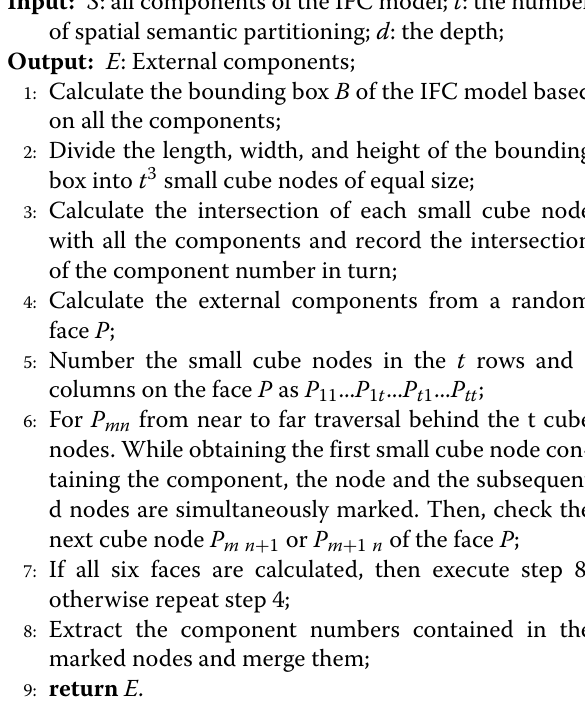
Algorithm 1 The pseudo-code of the